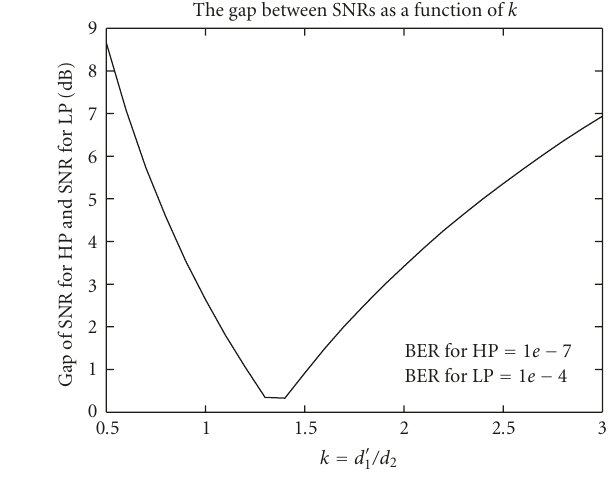
Figure 5: SNR Gap versus k curve.